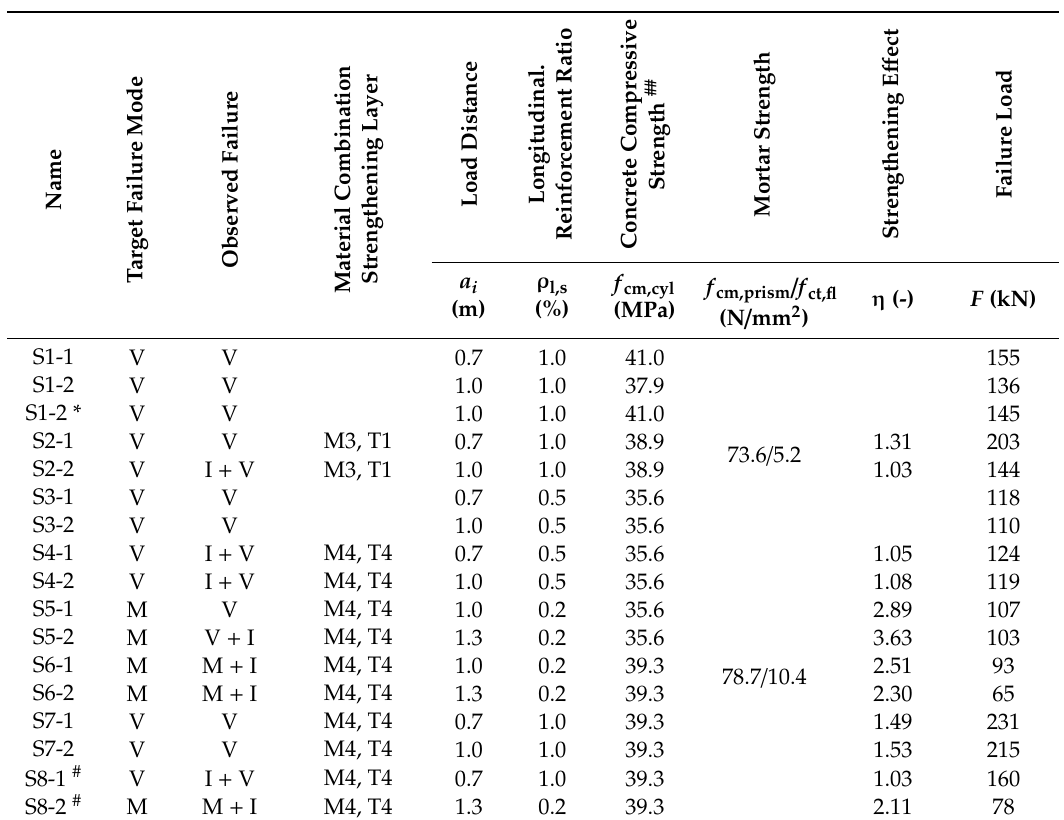
Table 2. Features of the large-scale